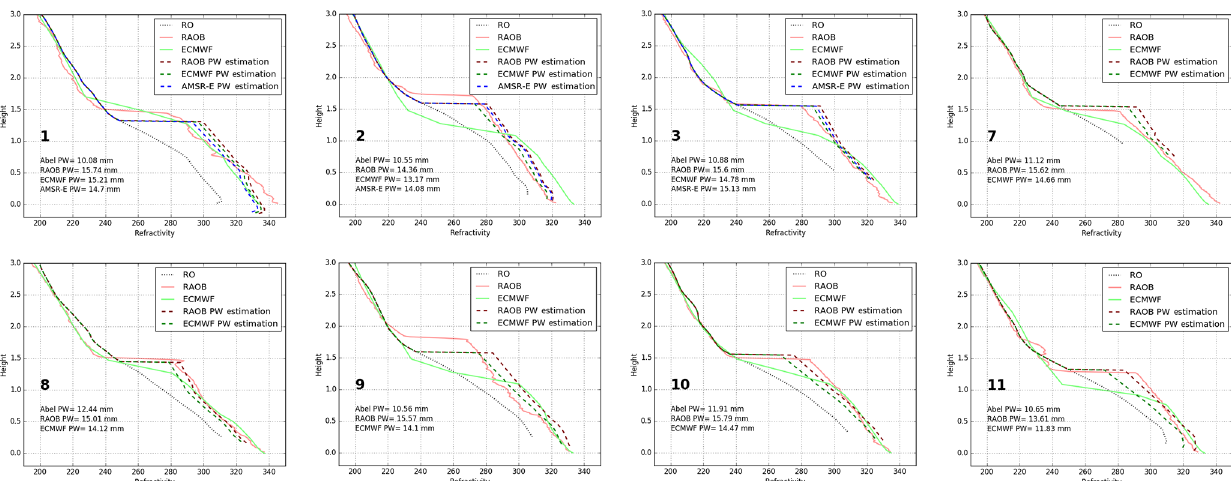
Figure 10. Refractivity profiles from the actual RO (dotted lines), collocated radiosonde measurements (solid red lines), ECMWF analysis (solid green lines), and reconstruction using RAOB (red dashed lines) and ECMWF-computed PW (green dashed lines) for the eight col- located cases in the VOCALS campaign. The reconstructed profiles using collocated AMSR-E measurements are also shown (blue dashed lines) in the first three cases. All case numbers are in the left side of each panel. Although the ducting layer heights in most cases are different from the RAOB profiles due to the distance and different footprints between the two observations, the RO reconstruction results are still able to correct the N -bias below the trapping layer with a higher amount of water vapor content measured by the AMSR-E or ECMWF model.